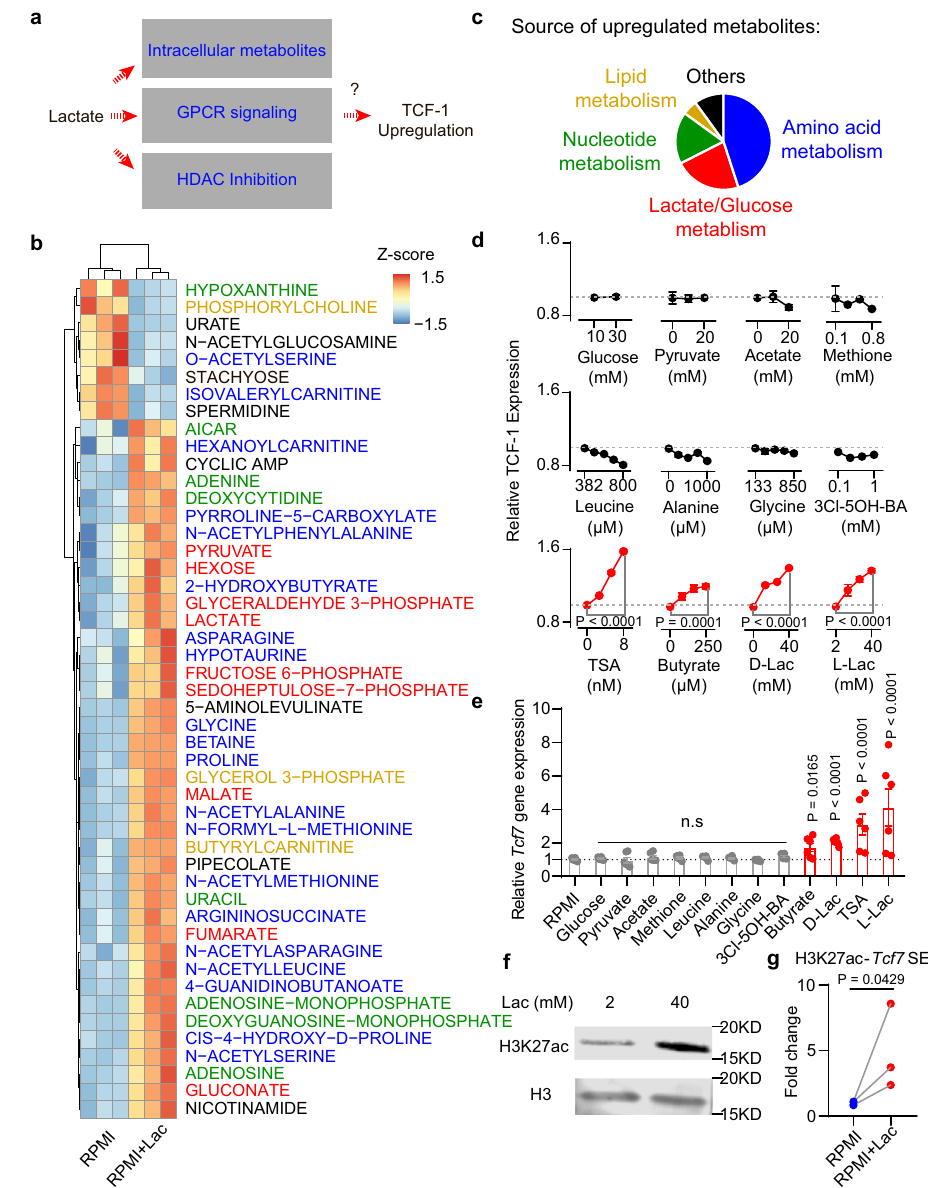
Fig. 6 | Lactate increases TCF-1 expression through inhibition of histone dea- cetylases(HDAC).a PotentialmechanismsforlactateinducedTCF-1upregulation. b Heatmap of signi fi cantly changed metabolites in CD8 + T cells treated with or without 40mM lactate. c Source of upregulated metabolites with 40mM lactate treatment. d TCF-1 protein expression in CD8 + T cells treated by different meta- bolites,GPCR agonistorHDACinhibitors( n =3biologicallyindependentsamples). e Gene expression of Tcf7 in CD8 + T cells treated by different metabolites, GPCR agonist or HDAC inhibitors. The concentration of different metabolites was the